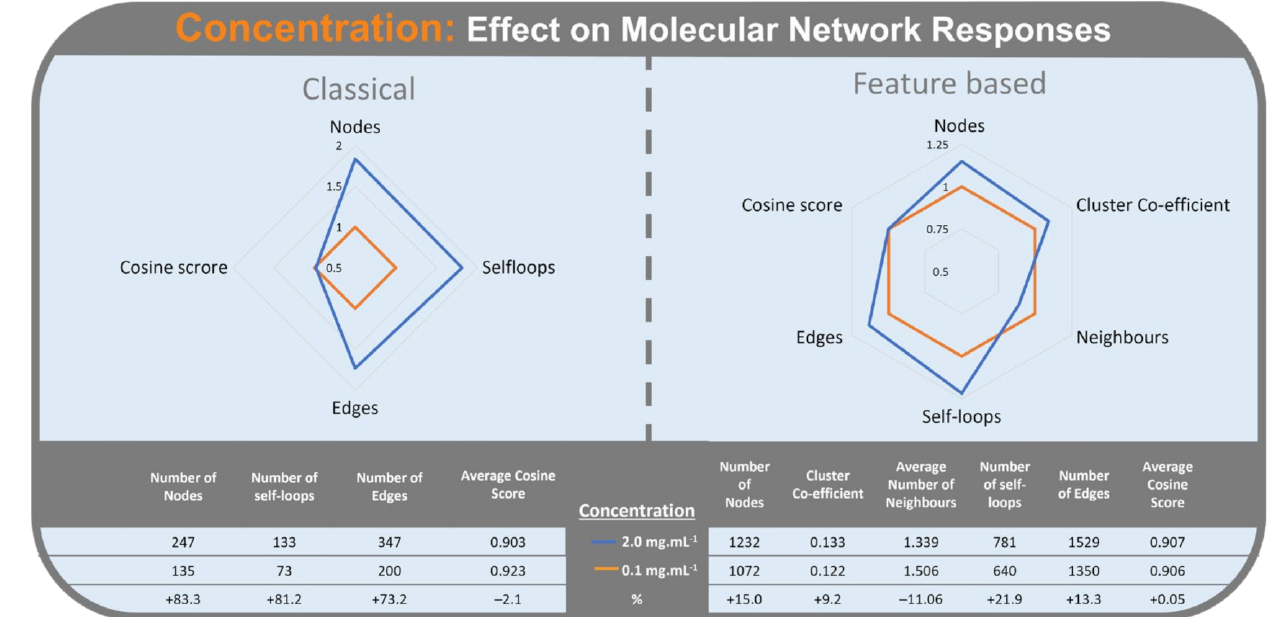
Figure 9. Radar graph of concentration (0.1 mg/mL in orange) (2.0 mg/mL in blue) on the rel- ative change of responses. Classical Molecular Networking ( left ) and Feature-Based Molecular Networking ( right